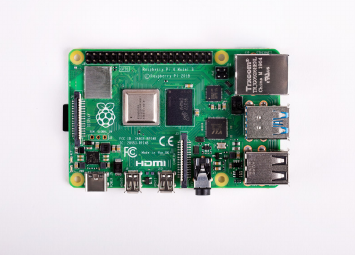
Figure 4. Edge computing device-raspberry pi